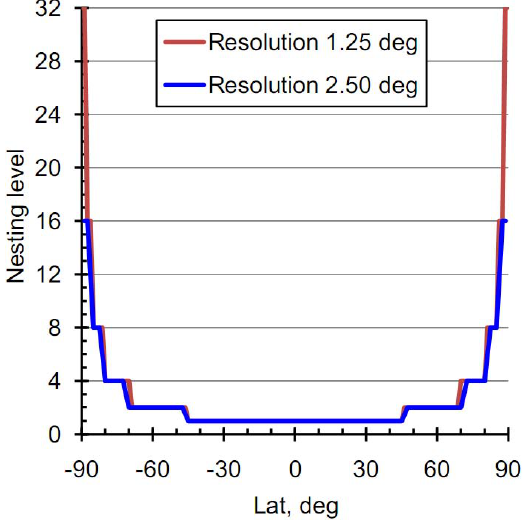
Fig. 2. Dependence of the nesting level on latitude for resolutions of 1.25 and 2.5 ◦